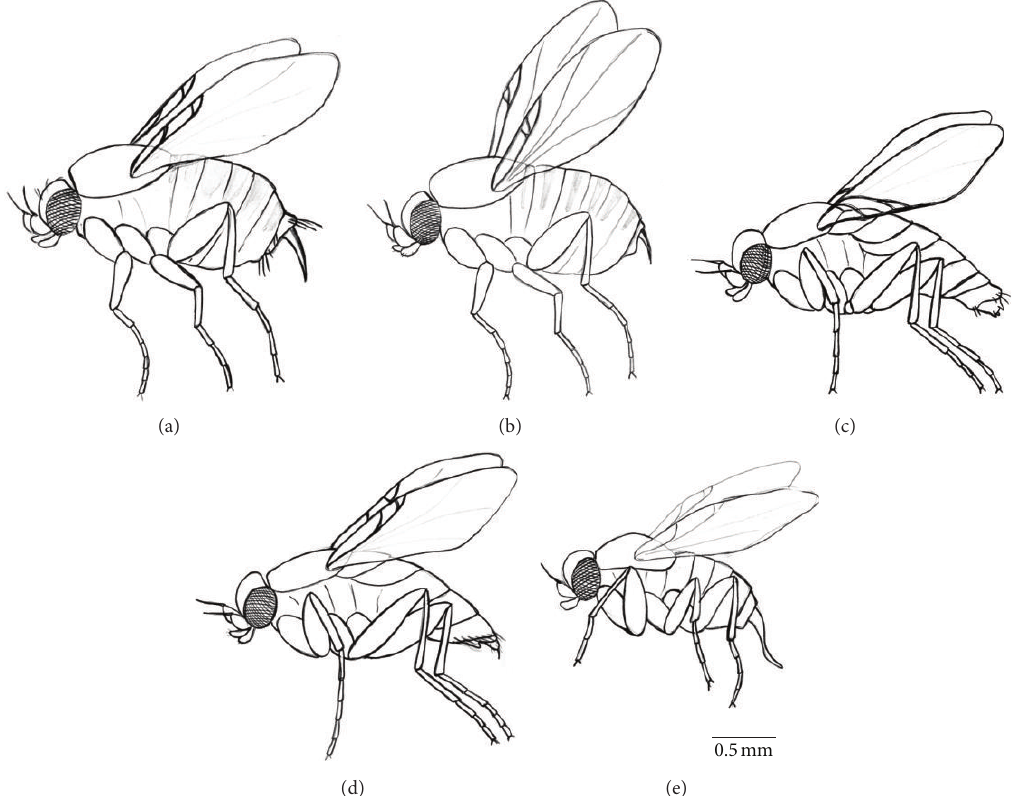
Figure 2: Schematic drawings of phorids showing details of the main characters that can be used to easily identify and distinguish among the main genera attacking leaf-cutter ants. Sizes represent real relative differences. (a) Apocephalus from the “attophilus” group and (b) from the “ grandipalpis ” group, (c) Eibesfeldtphora, (d) Neodohrniphora , and (e) Myrmosicarius